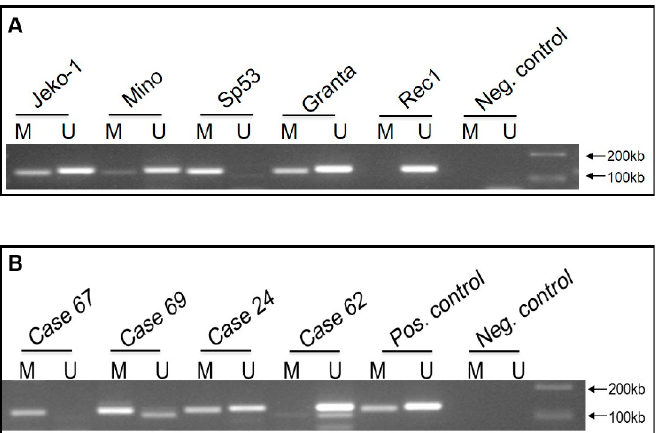
Figure 2. High methylation status of the WIF1 promoter region in MCL cell lines and patients. ( A ) Methylation-specific PCR of the WIF1 promoter region was performed on 5 MCL cell lines. With the exception of REC1, signals from the methylation-specific PCR were readily detectable. ( B ) Methylation-specific PCR of WIF1 promoter region performed on 4 MCL patient samples. M indi- cates primer specific for methylated site, U indicates primer specific for unmethylated site. Neg indicates no DNA negative control. Table 1. A significant correlation between the high expression of pGSK-3 β and WIF1 methylation in 29 cases of mantle cell lymphoma.